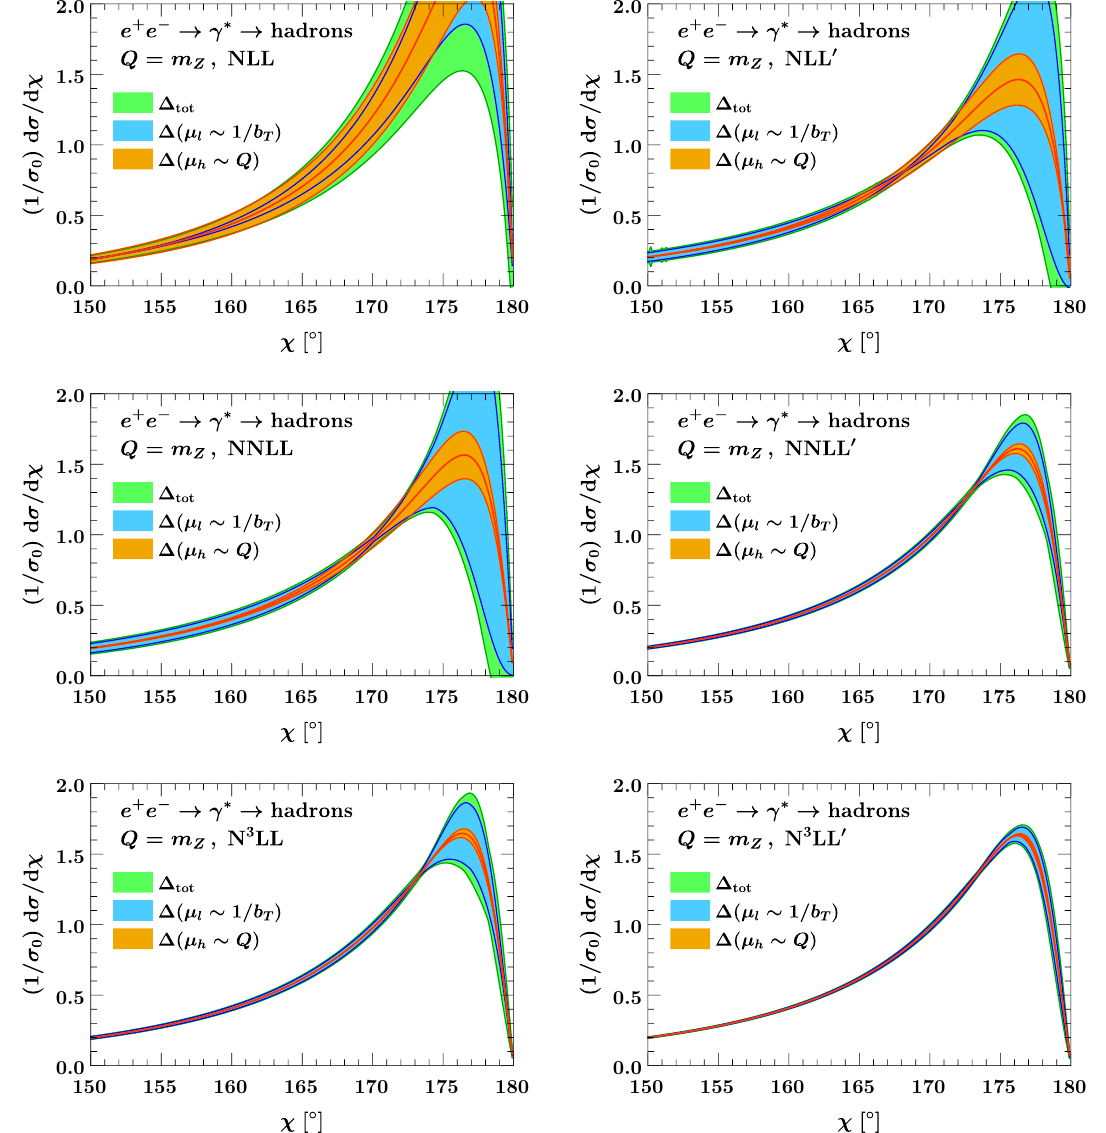
Figure 4 . Comparison of the total uncertainty ∆ tot , estimated by a full set of profile scale varia- tions, to varying only the high scales µ h ∼ Q or the low scales µ l ∼ 1 /b T . See text for more details.